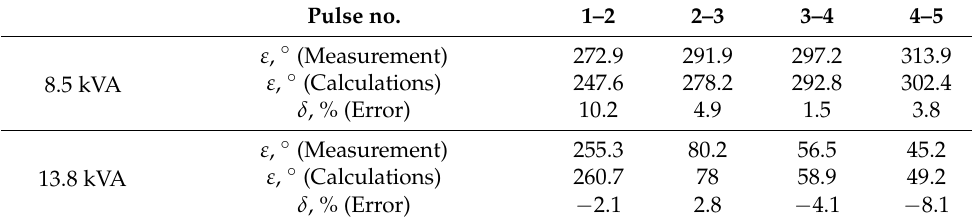
Table 6. Comparison of the duration of the out-of-current interruptions between current pulses. Pulse